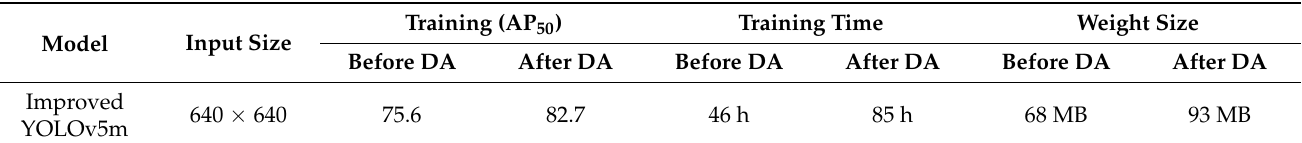
Table 6. Precision of improved YOLOv5m during training process.